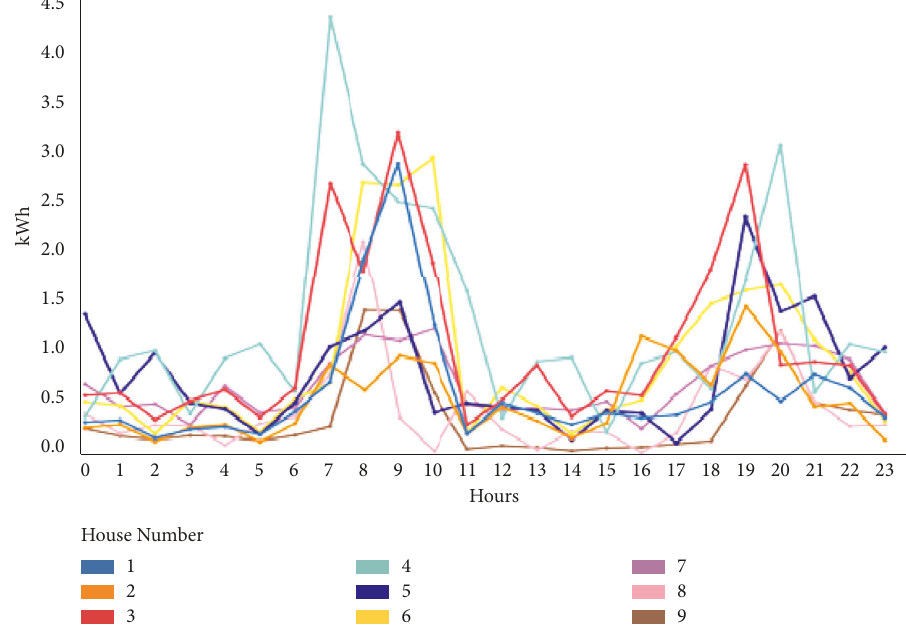
Figure 6: Average hourly load profiles of 9 consumers for a nonsummer month, January.